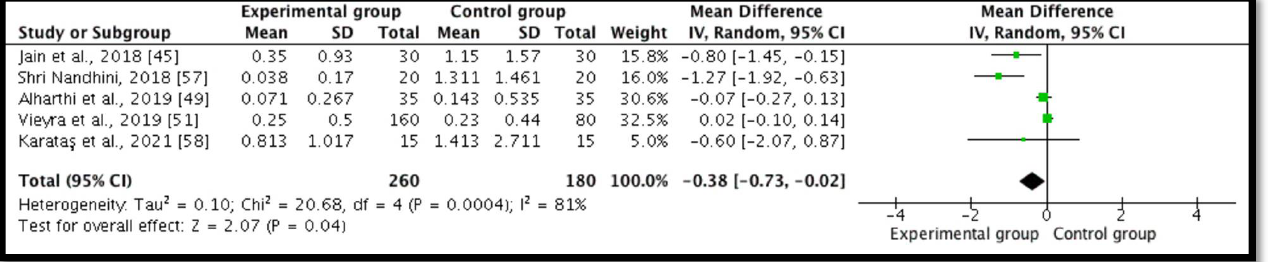
Figure 5. Forest plot comparing postoperative pain between the experimental group (intracanal cryotherapy) and the control group (room temperature) at 48 h.